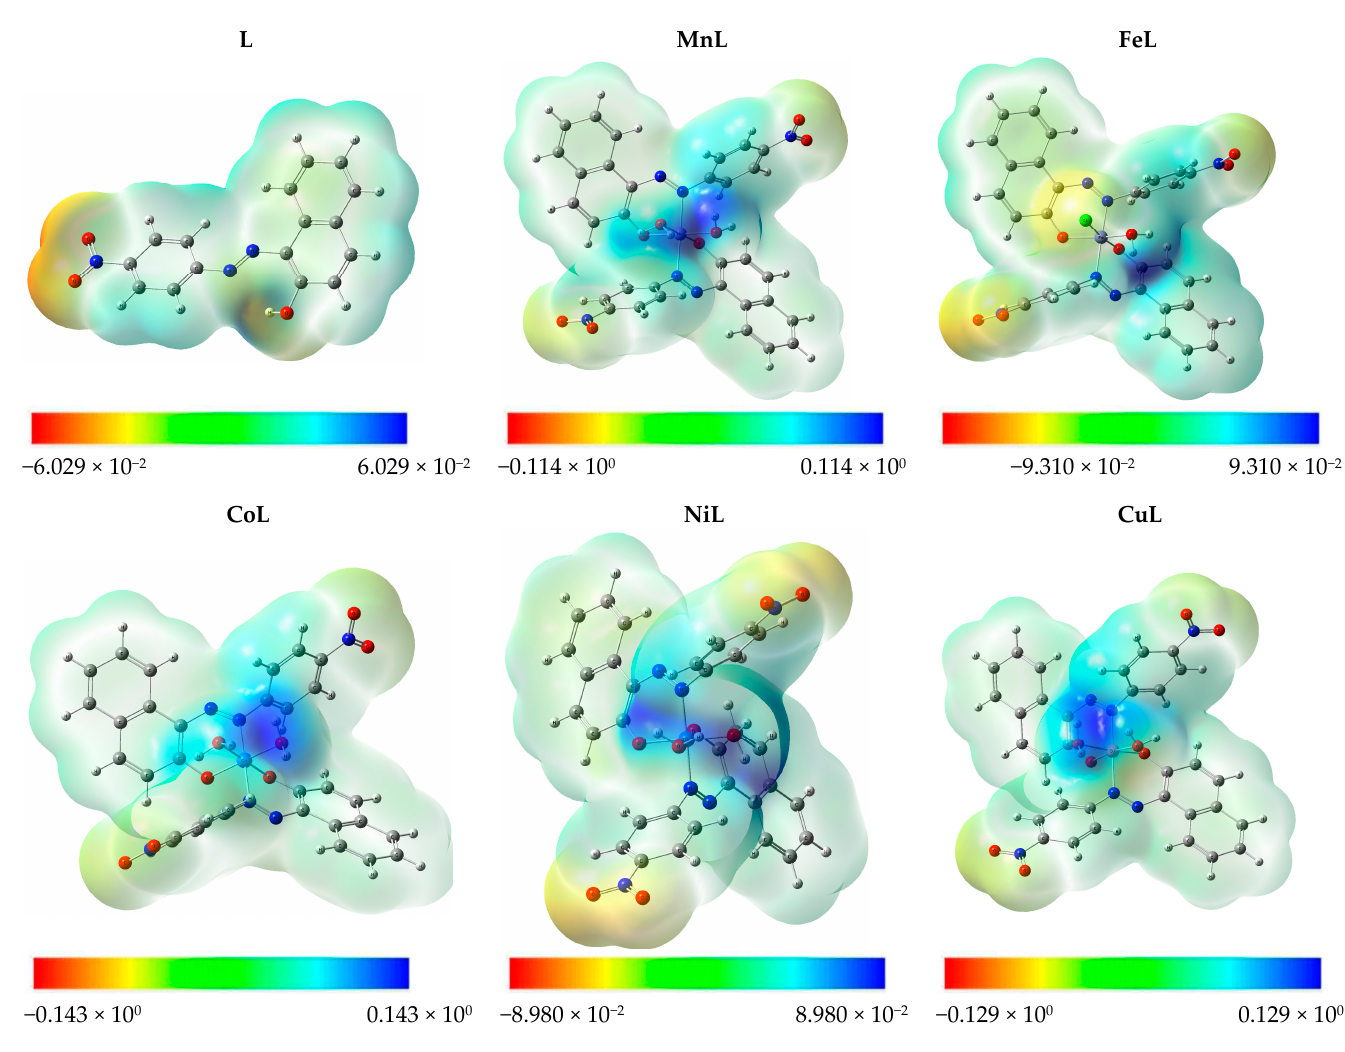
Figure 4. MEP of the compounds.